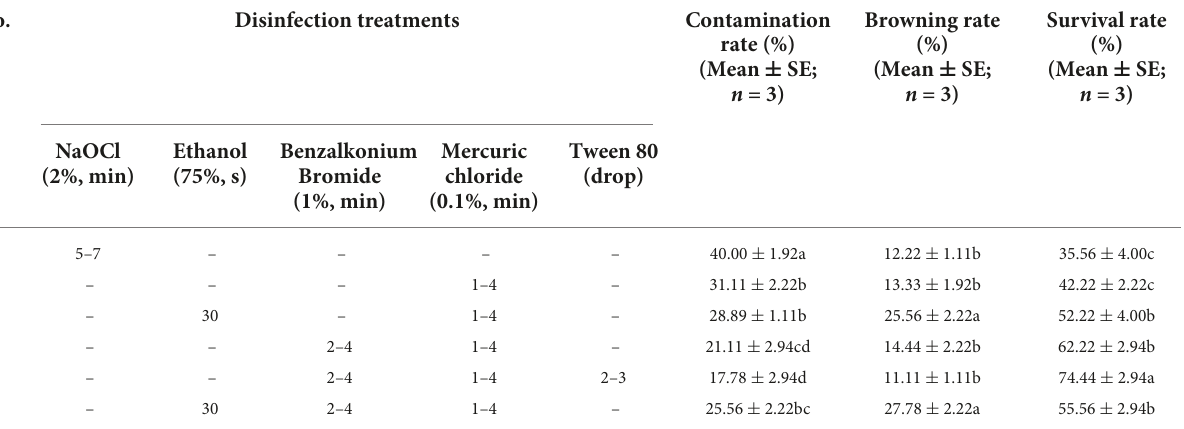
Thedisinfectiontimeofbenzalkoniumbromideandmercuricchloridedependedonthedegreeoflignificationoftheexplants.Afterdisinfectionwithdisinfectantagent,allexplantswere rinsed four times with sterile distilled water. Different lowercase letters in the same column indicate significant differences, as per Duncan’s multiple range test (p ≤ 0.05, n = 3 indicates threereplicates). TABLE 2 Effects of different basal media on initial shoot sprouting. No.